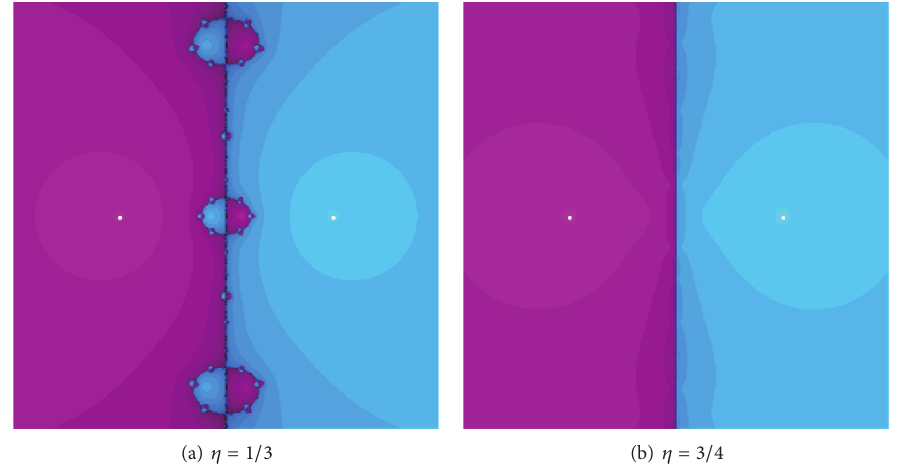
Figure 2: Basins of attraction for different methods of family (14) for 𝑓(𝑥) = 𝑥 2 − 1 shaded according to the number of